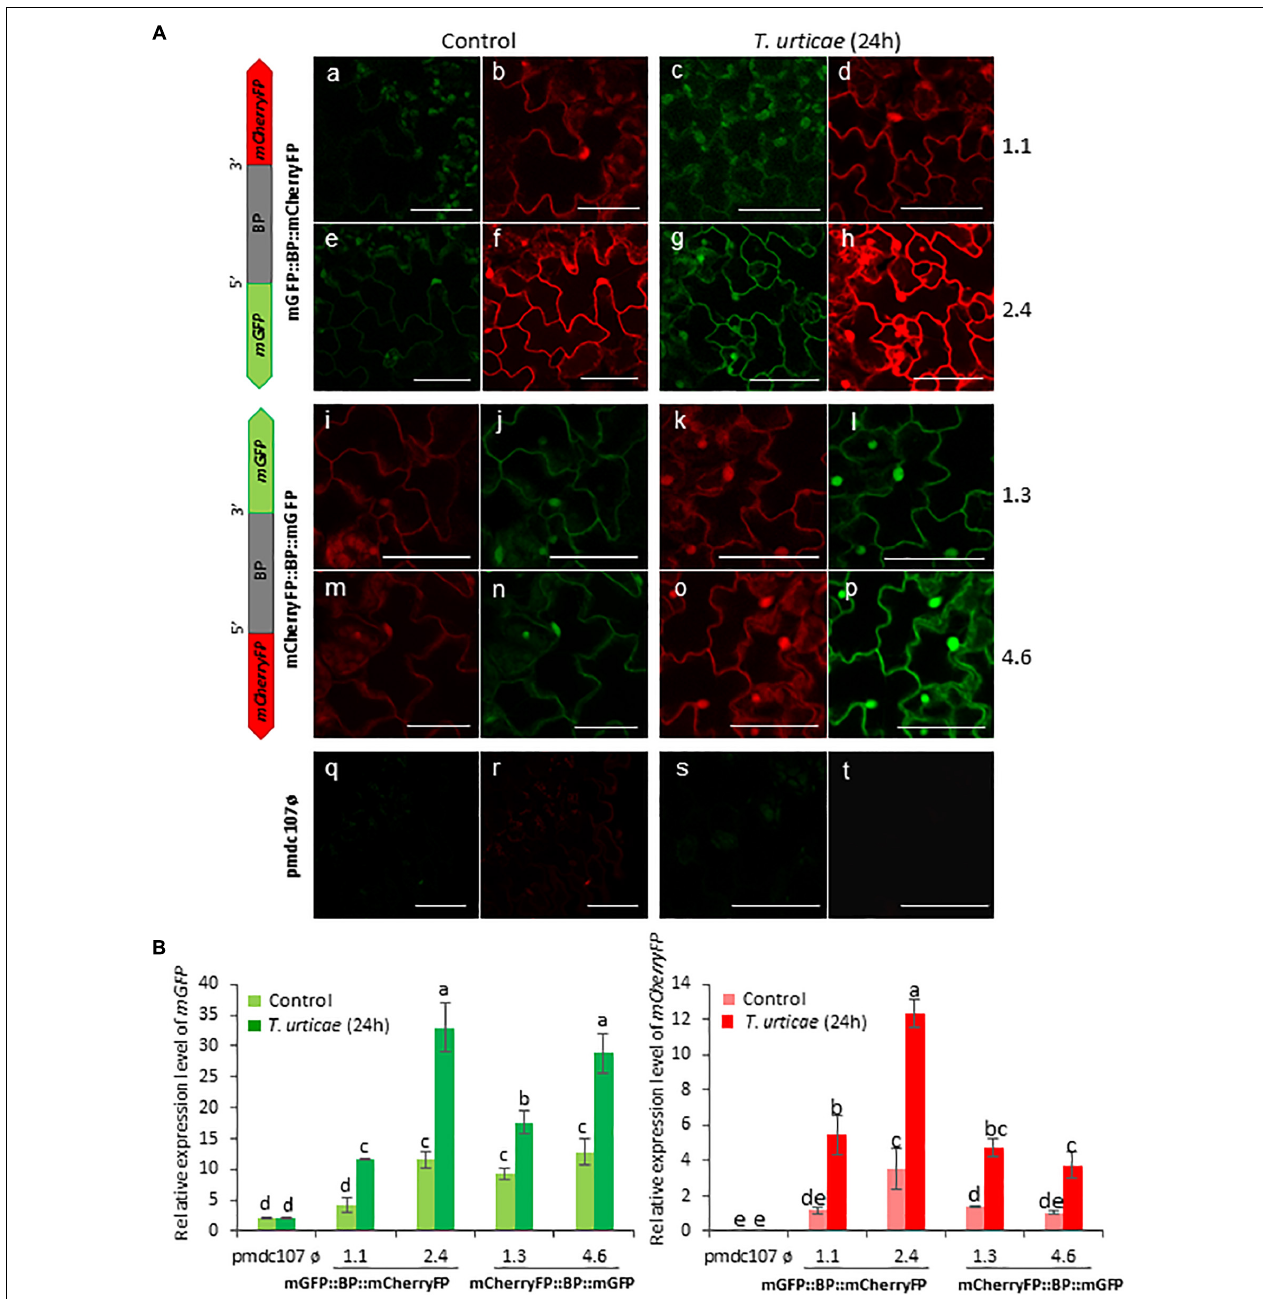
FIGURE 4 | Schematic representation of fusion-constructs and expression assays in stably transformed Arabidopsis plants in response to T. urticae infestation. (A) Scheme of mCherryFP and mGFP genes under the bidirectional promoter (BD) and confocal stacks spanning Arabidopsis epidermal cells of transformed leaves under control conditions, and after T. urticae infestation. Projections are from mCherryFP (b,d,f,h,i,k,m,o,r,t) and mGFP (a,c,e,g,j,l,n,p,q,s) . Bars are 50 µ m. (B) Quantitative analyses of mGFP and mCherryFP gene expression in stably transformed Arabidopsis plants in control, and after 24 h of T. urticae infestation. Bars in green and red colors correspond to mGFP and mCherryFP gene expression, respectively. Data are ± SE of three biological replicates. Different letters indicate statistical differences ( P < 0.05 Wald χ 2 followed by LSD test). Arabidopsis transformed lines for mGFP::BP:mCherryFP construct were 1.1 and 2.4, and for mCherryFP:BP::mGFP were 1.3 and 4.6. Primers used for this experiment are listed in Supplementary Table 1